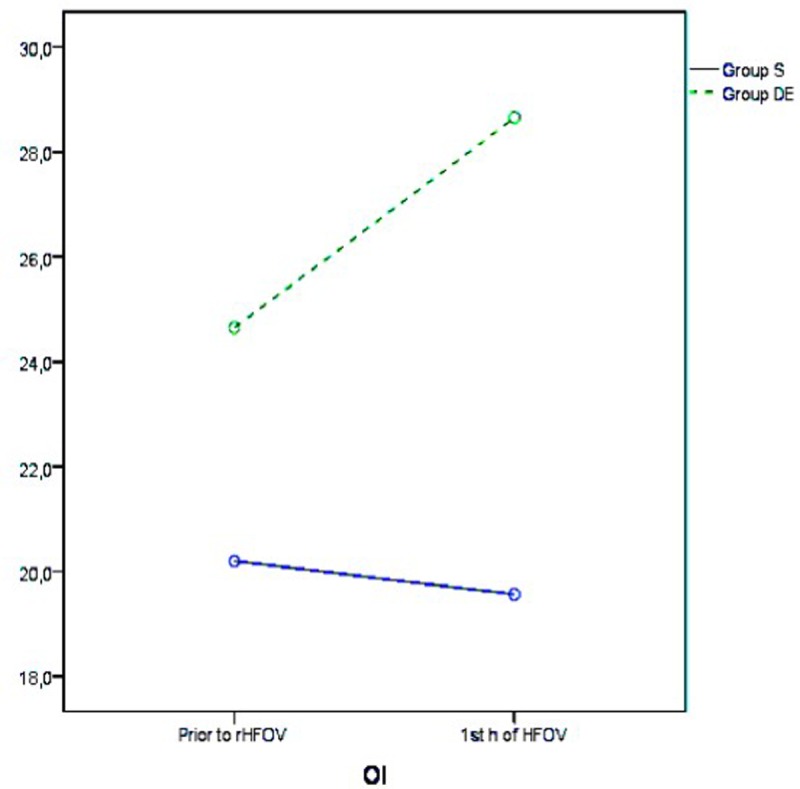
Evolution of OI.